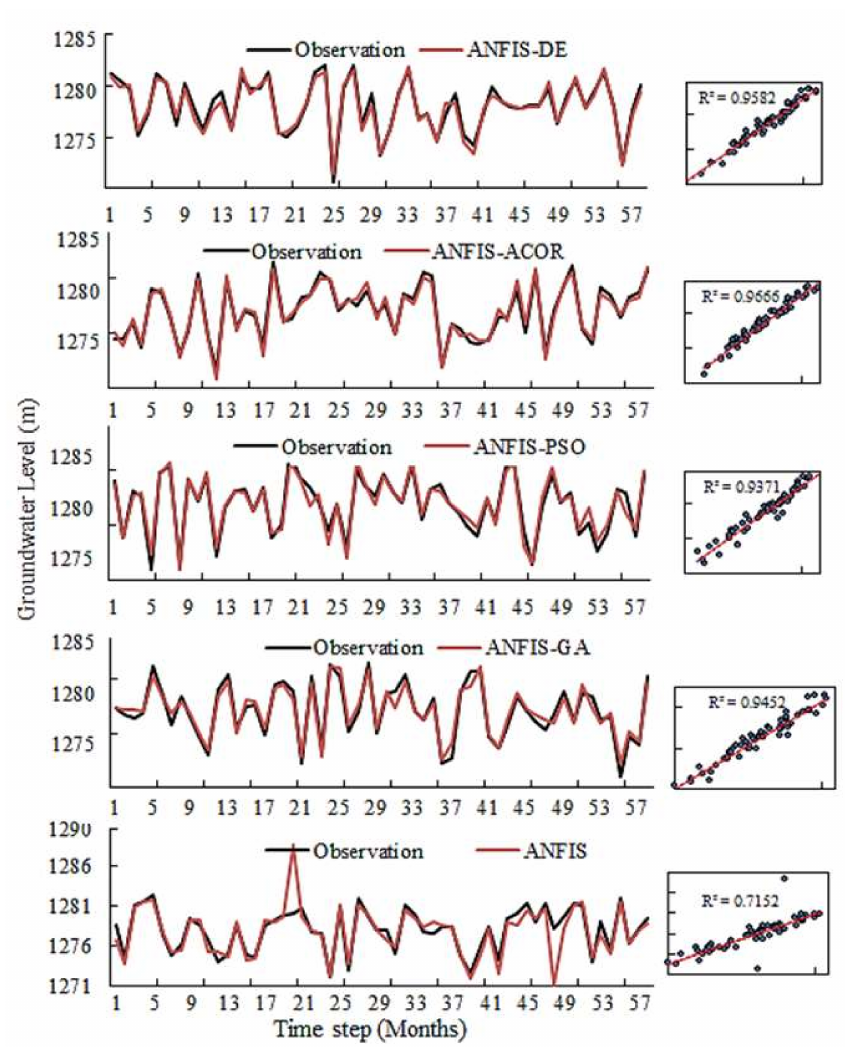
Figure 9. Observations and predictions for well P2. Taylor’s diagram for the selected input patterns for observation well P2 is shown in Figure 10. For the ANFIS-ACOR model, the correlation coefficient is about 0.98, which indicates efficient prediction. The standard deviation for both observations and predictions obtained by this model was similar and equal to 2.6 m. The correlation coefficient, standard deviation, and RMSD for other models were similar. The standard deviation of the ANFIS- PSO was close to that of the observation